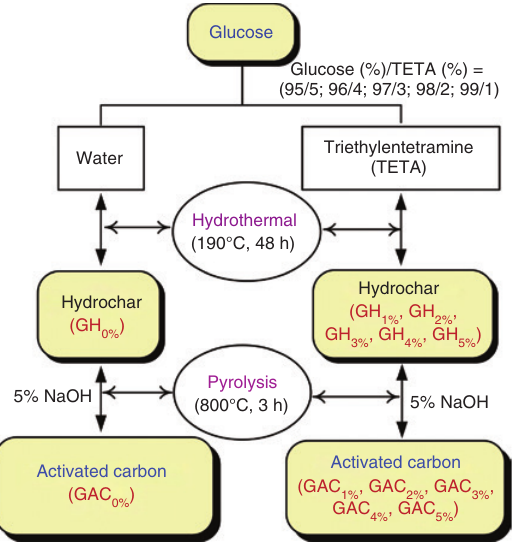
Figure 1: Schematic illustration of the preparation procedure for the